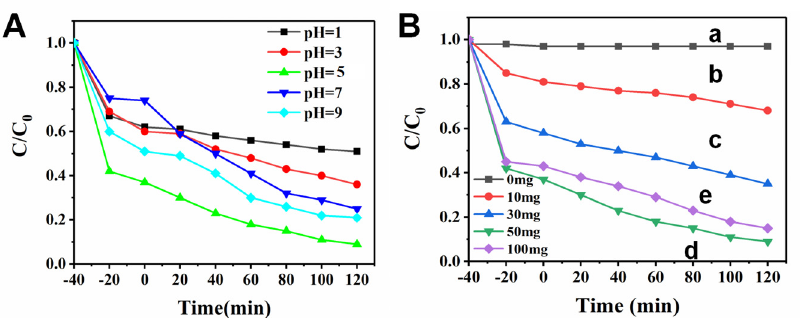
Figure 5. ( A ) The effects of pH and ( B ) ZnS/CuS amount (line a~e: 0, 10, 30, 50, and 100 mg) on the TC degradation. The time of dark reaction for adsorption is − 40~0 min.